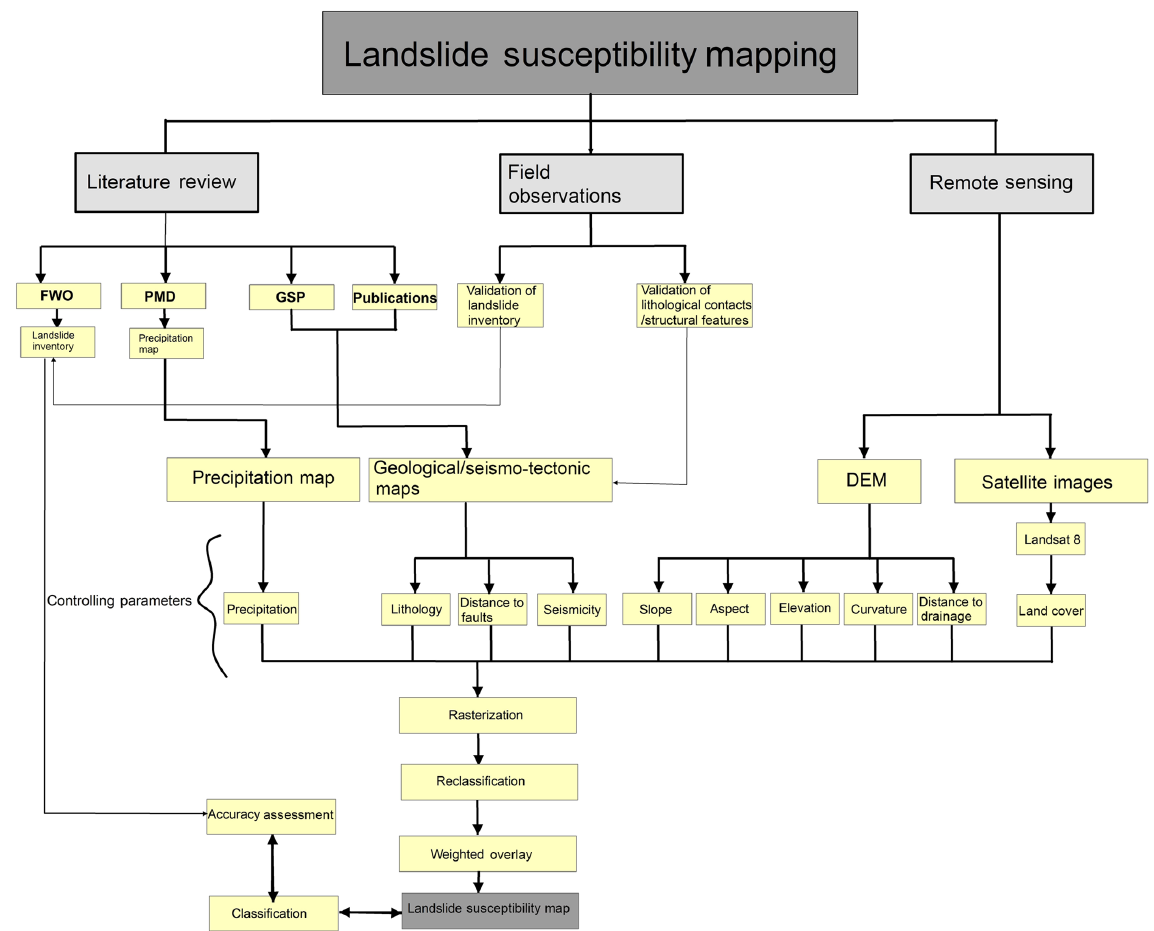
Figure 5. Flow chart showing multiple steps involved in the preparation of the susceptibility map: FWO is Frontier Works Organization, PMD is Pakistan Meteorological Department, GSP is Geological Survey of Pakistan and DEM is digital elevation